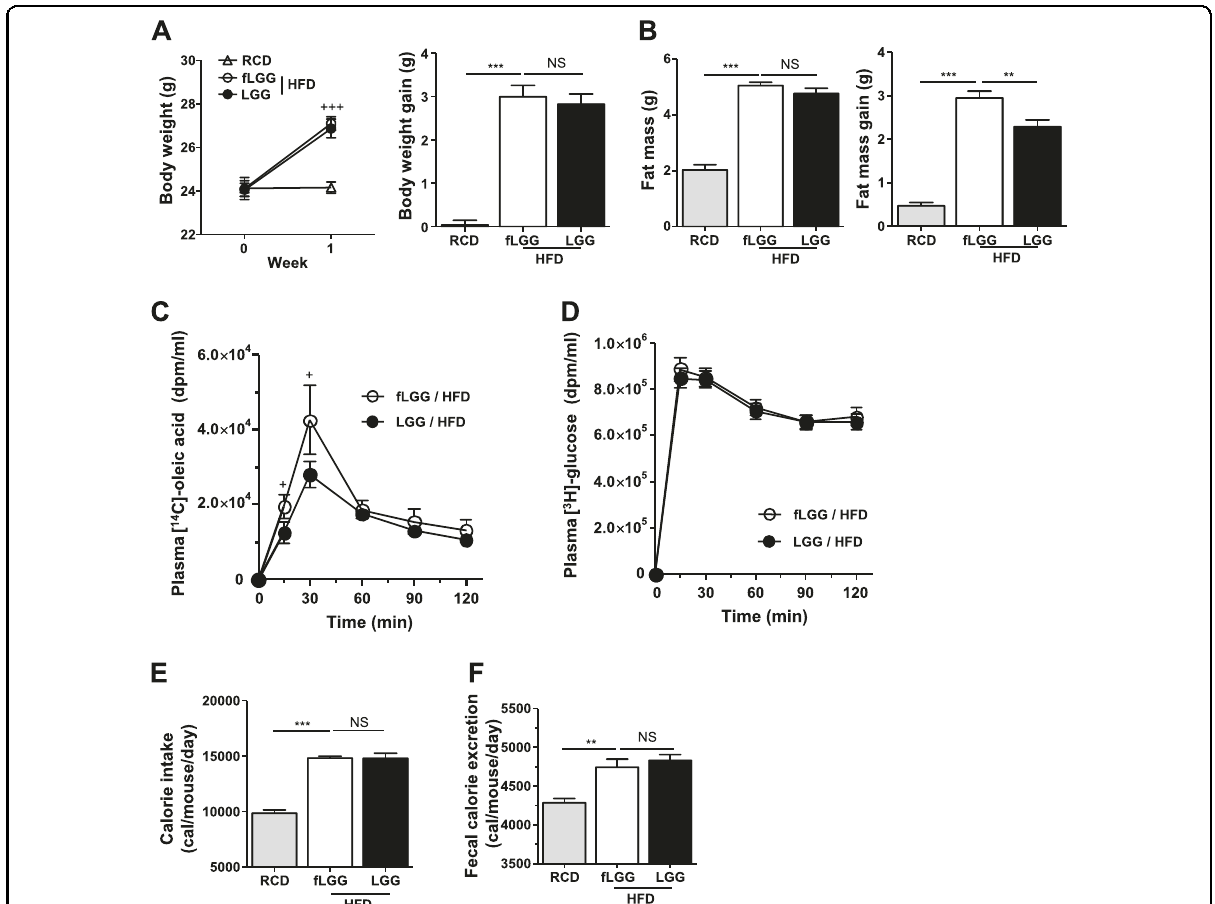
Fig. 4 In vivo, Lactobacillus rhamnosus GG reduces fat mass gain and intestinal lipid absorption during a short-term HFD study. a Left panel: body weight change curve during experimental periods; right panel: body weight gain. b Left panel: fat mass; right panel: fat mass gain. c [ 14 C]-OA radioactivity measured in plasma. d [ 3 H]-glucose radioactivity measured in plasma. e Calorie intake. f Fecal calorie excretion. Data are expressed as the mean ± SEM ( n = 5 – 7 per group). + P < 0.05 and +++ P < 0.001 by two-way ANOVA and ** P < 0.01 and *** P < 0.001 by